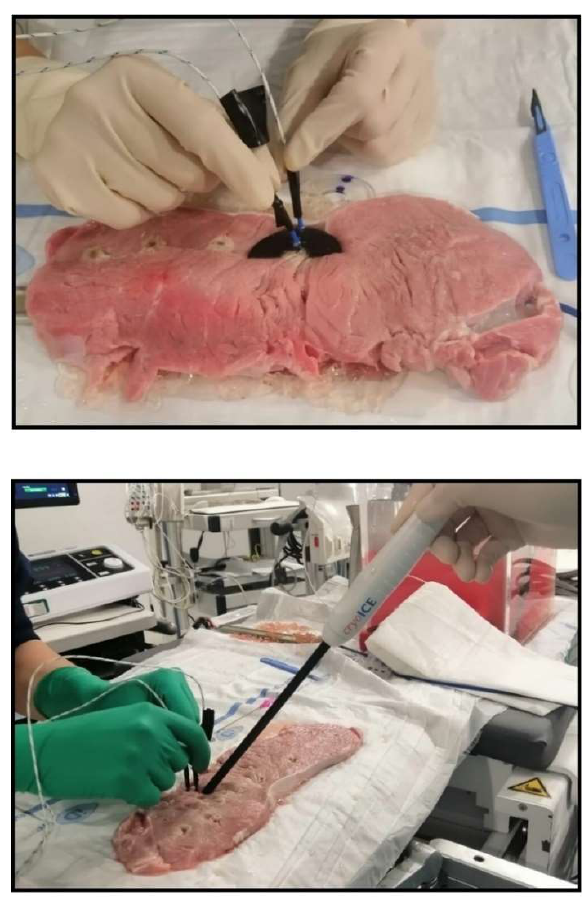
Figure 2. Experimental tests. Thermal test: upper panel. Biomaterial and thermocouple placement: lower panel. cryoICE catheter in place.